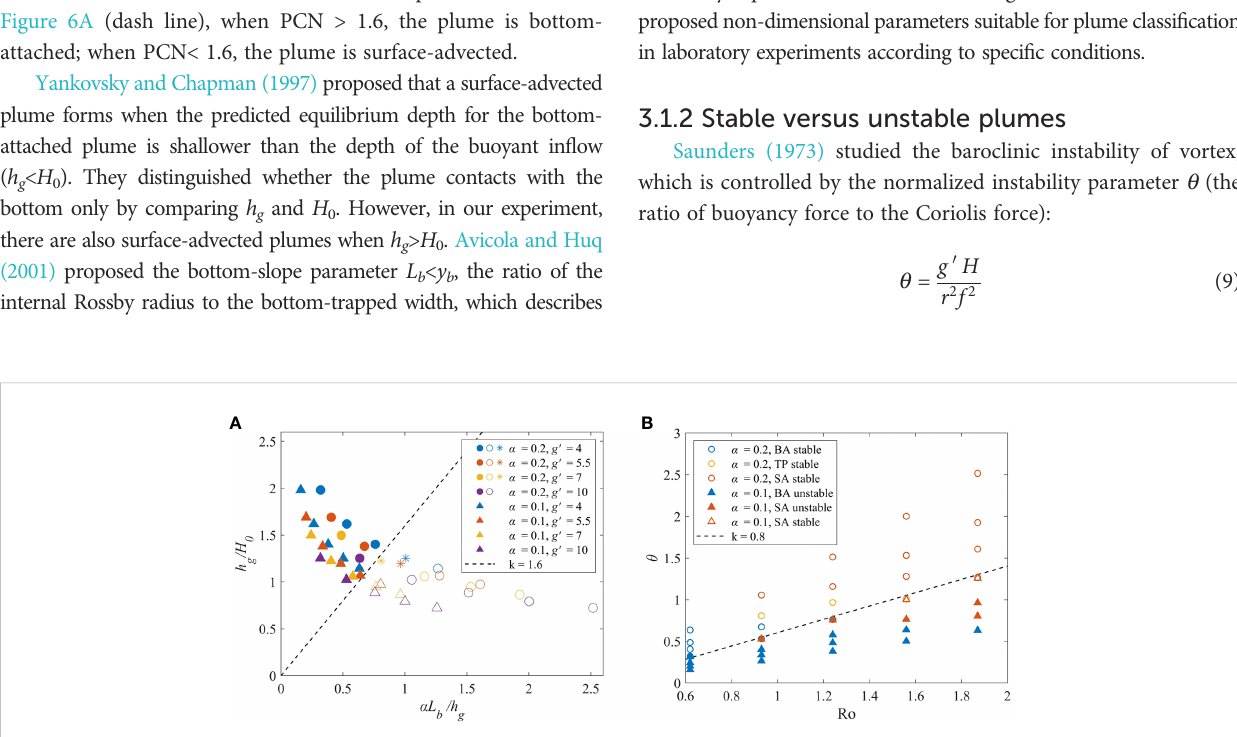
FIGURE 6 Plume types according to the bottom attachment (A) or bulge stability (B) . In panel (A) , the solid, asterisk and hollow symbols represent bottom- attached plumes, transitional plumes, and surface-advected plumes, respectively. The dash line denotes the boundary of surface-advected and bottom-attached plume, which is PCN = 1.6. In panel (B) , the solid and the hollow symbols represent unstable and stable plumes, respectively. The dash line stands for the boundary of stable and unstable plume, which is BIN = 0.8.